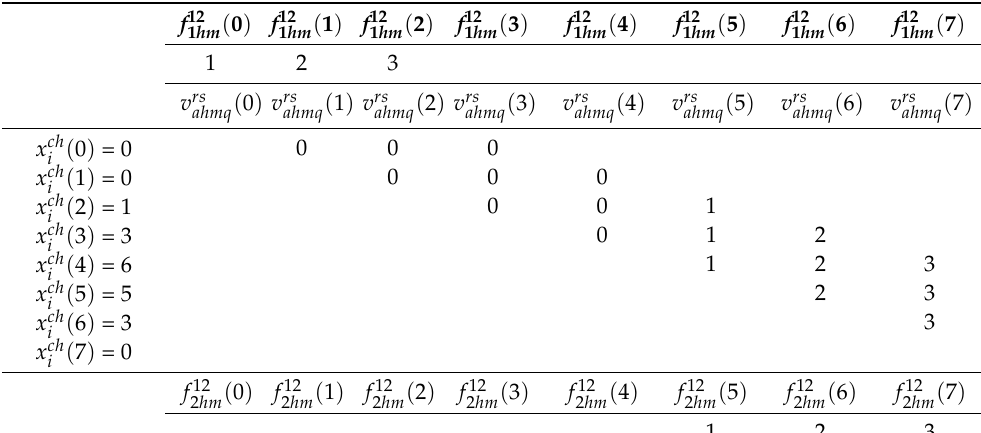
Table 2. Example of FCS vehicle number statistics.